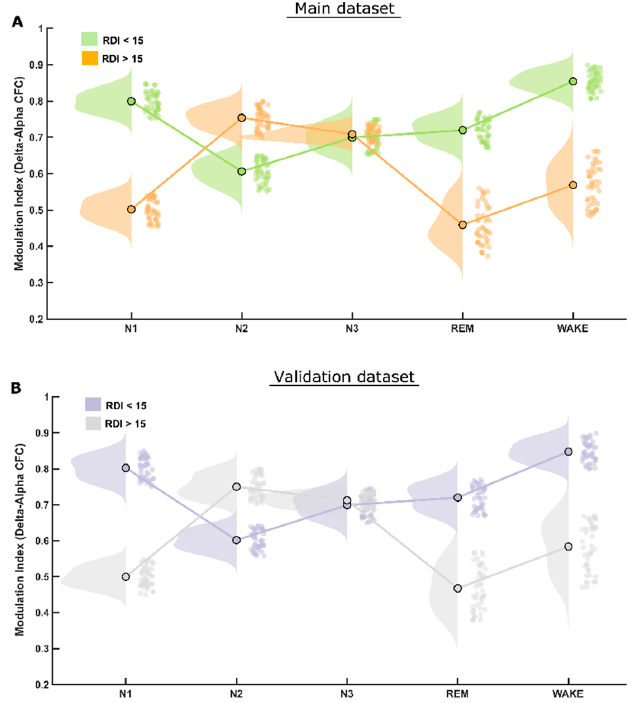
Figure 3. MI differences in delta–alpha CFC. ( A ) The raincloud plot illustrates that patients of the RDI > 15/h group have significantly lower delta–alpha CFC modulation index than those in REM and N1 sleep stages and significantly higher MI in N2 sleep stage than that of patients in the RDI ≤ 15/h group. The delta–alpha CFC modulation index in NREM ‐ 3 (N3) sleep stage is almost identical in the two patient groups. ( B ) Of note, exactly the same pattern was found again in both the initial and the validation datasets.